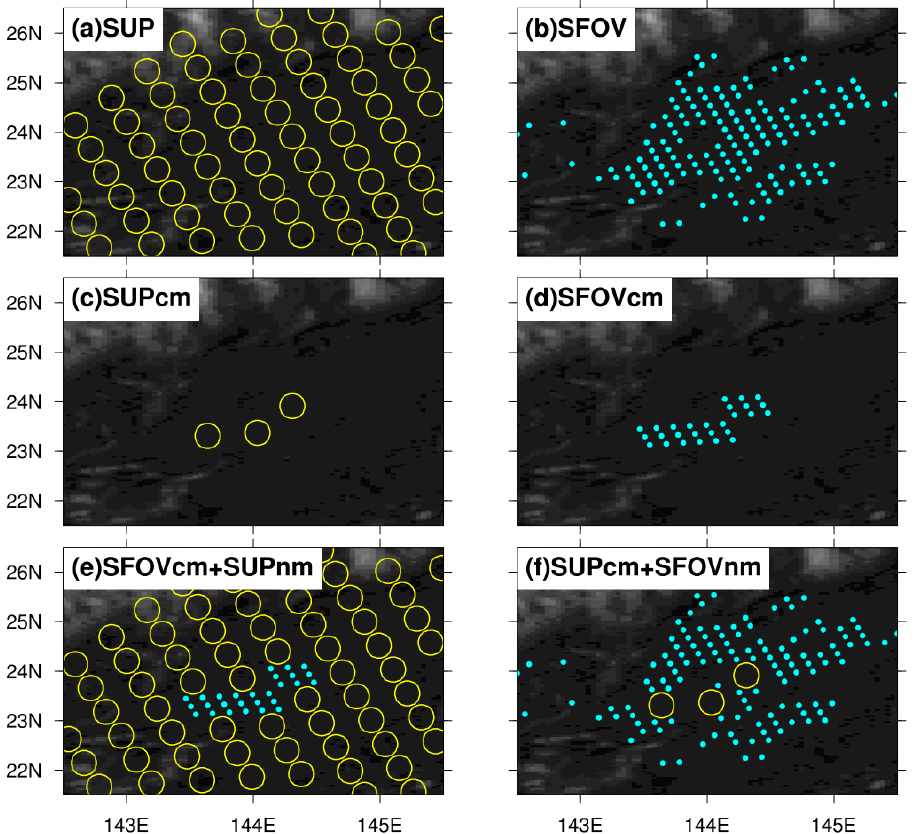
Figure 4. The conceptual sounding data spatial distribution for the experiments in the study: ( a , b ) “SUP” and “SFOV”; ( c , d ) “SUPcm” and “SFOVcm”); and ( e , f ) “SFOVcm+SUPnm” and “SUPcm+SFOVnm”. See Tables 1 and 2 for the detail cross-matched (cm) and non-matched (nm) descriptions.